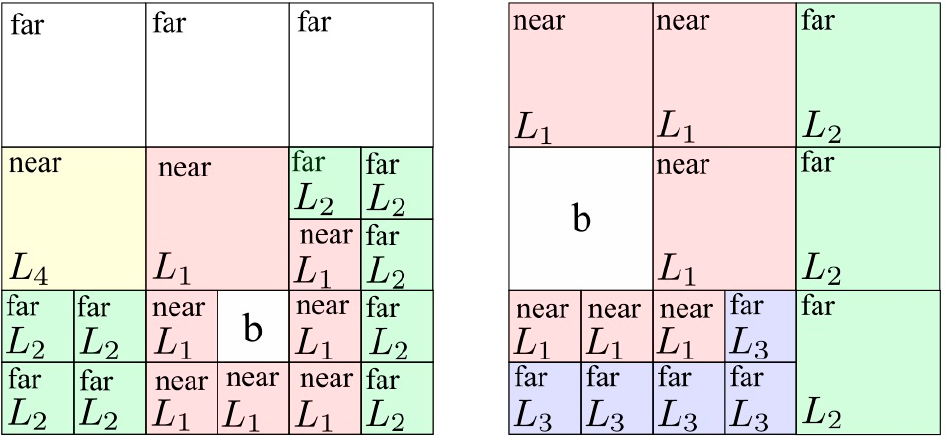
Figure A1. The four lists used to define L near ( b ) , L far ( b ) associated for a given field box b . The sources boxes are depicted as: (i) pink and yellow for near interactions, and (ii) green and violet for the far interactions. Note that in left figure there are some empty source boxes. These boxes refer to the previous level far box–box interaction (indeed with the father of b ). So actually, they are not present in L far ( b )